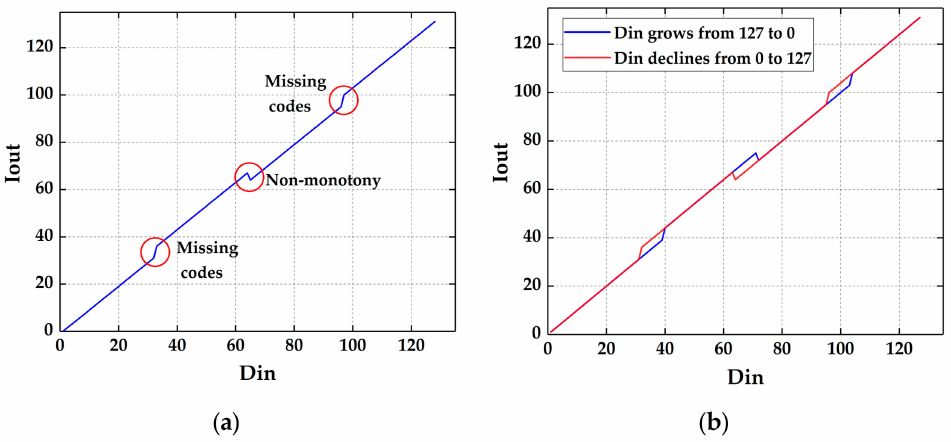
Figure 9. The conversion characteristic of ( a ) non-ideal 7-bit DAC and ( b ) 8-bit DAC based on proposed